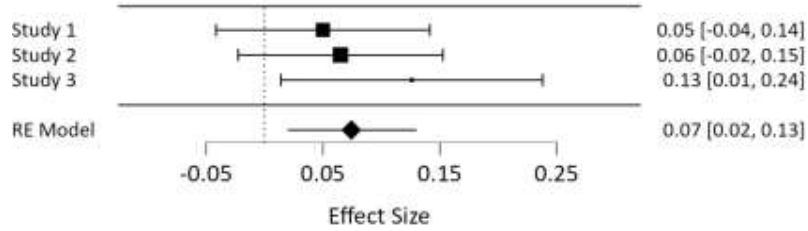
Figure 13. Forest plot of meta-analysis of Motivation for knowledge and Conscientiousness Motivation for achievement